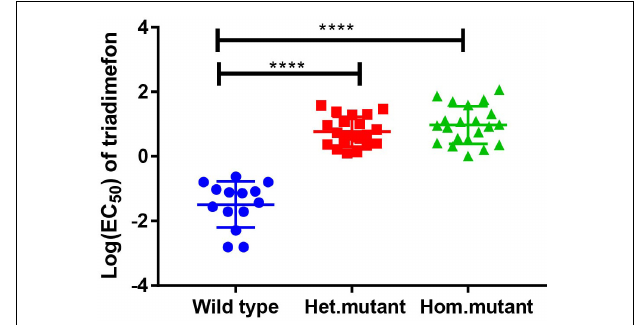
FIGURE 1 | Responses of the parental isolate and progeny isolates to triadimefon (estimated as EC 50 ) and t -test of different genotypes ( ∗∗∗∗ P <